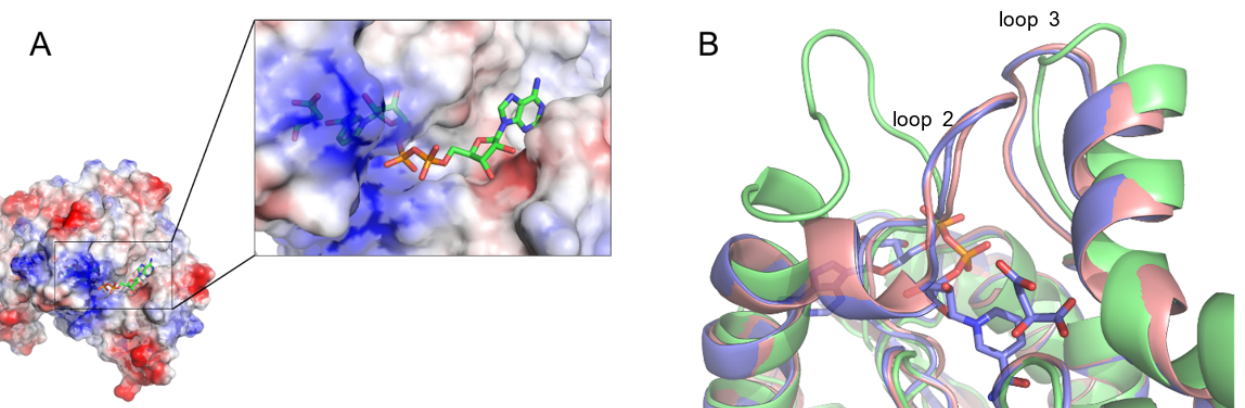
Figure S3: Multiple sequence alignment of hMDH2 and its homologues; Figure S4: Suggested the mechanism of the substrate specificity; Figure S5: Enzymatic activity of hMDH2 in phosphate, HEPES, and Tric-HCl buffers; Figure S6: Composite (2 F o − F c , gray, contoured at 1 σ ) and difference ( F o − F c , blue/red, contoured at 3 σ ) electron density maps of hMDH2; Table S1: Hydrogen bond interactions across the dimeric interface; Table S2: Surface area comparisons of different ligands bound to hMDH2 structures; Table S3: Hydrogen bond interactions of hMDH2 and